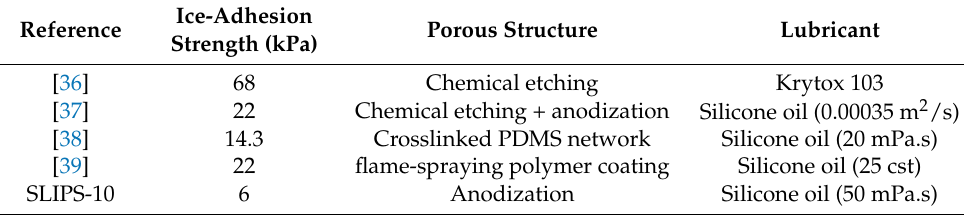
Figure 4. ( a ) Ice-adhesion strength test device. ( b ) Ice-adhesion strength of SLIPS with different anodizing times. Table 1. Comparison of the ice-adhesion strength of SLIPS prepared by different